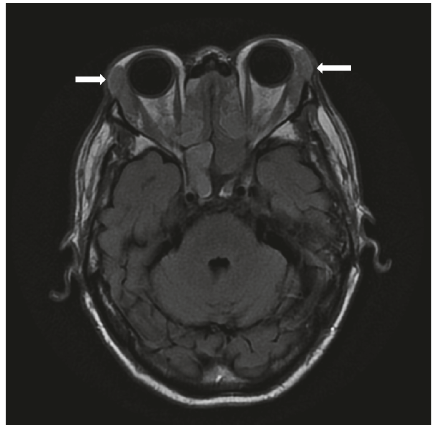
Figure 1: MRI brain showing bilateral enlargement (arrows) of the lacrimal